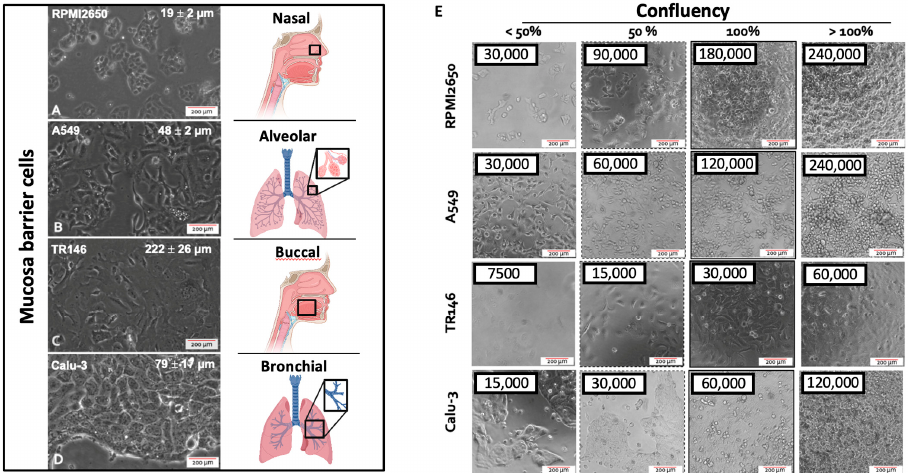
Figure 1. ( A – D ) Representative phase contrast images of cell morphology of the four different mucosa cell lines including ( A ) RPMI2650 (nasal), ( B ) A549 (alveolar), ( C ) TR146 (buccal), and ( D ) Calu-3 (bronchial) grown as conventional 2D monocultures in 75 cm 2 cell culture flasks. ( E ) Representative phase contrast images of the four epithelial mucosal cell lines at various monolayer confluency resulting from variations of initial cell seeding densities 24 h post-seeding in cell culture-treated 96-well plate format with a total growth area of 0.33 cm 2 . As shown in Figure 1A, RPMI2650 epithelial cells derived from squamous cell carci- noma of the nasal mucosa showed a tendency to grow in small patches. The very small ovoid to squamous appearing cells displayed an average size of 19.3 ± 2.3 µm reaching confluency of approximately 95% at an initial cell seeding density of 6 × 10 5 cells/cm 2 . In turn, A549 cells, which are epithelial cells of adenocarcinoma of the alveolar lung epithe- lium, revealed a characteristic spindle-like morphology when seeded below confluency with an average size of 47.4 ± 5.2 µm. Growing in bigger patches this alveolar cell type reached confluency at an initial seeding density of 4 × 10 5 cells/cm 2 . Interestingly, TR146, a squamous cell carcinoma cell line of the buccal epithelium displayed the biggest cell size of 222.3 ± 25.9 µm producing cell monolayers when seeded at approximately 1 × 10 5 cells/cm 2 ; while Calu-3 being a bronchial adenocarcinoma cell line displayed an average size of 79.1 ± 16.6 µm with confluency at a seeding density of 1.8 × 10 5 cell/cm 2 .